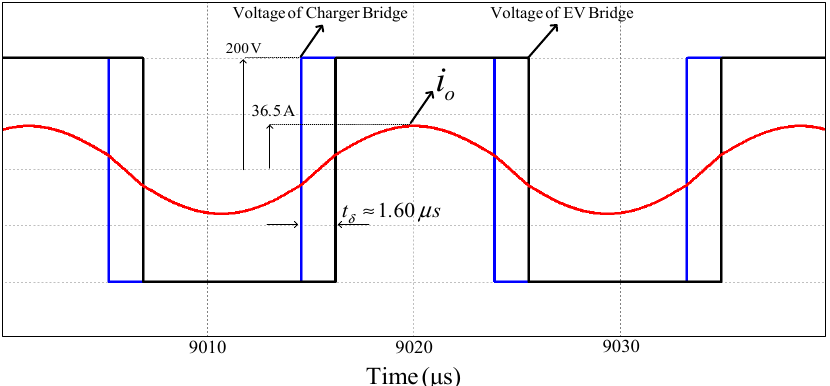
Figure 7. Output voltage of charger bridge, EV bridge and i o under equal voltages condition with τ 1 = 10 µs and τ 2 = 1 µs.